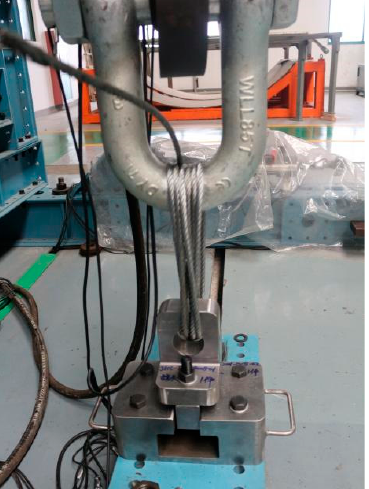
Figure 2. Overall condition after pull-off test installation.